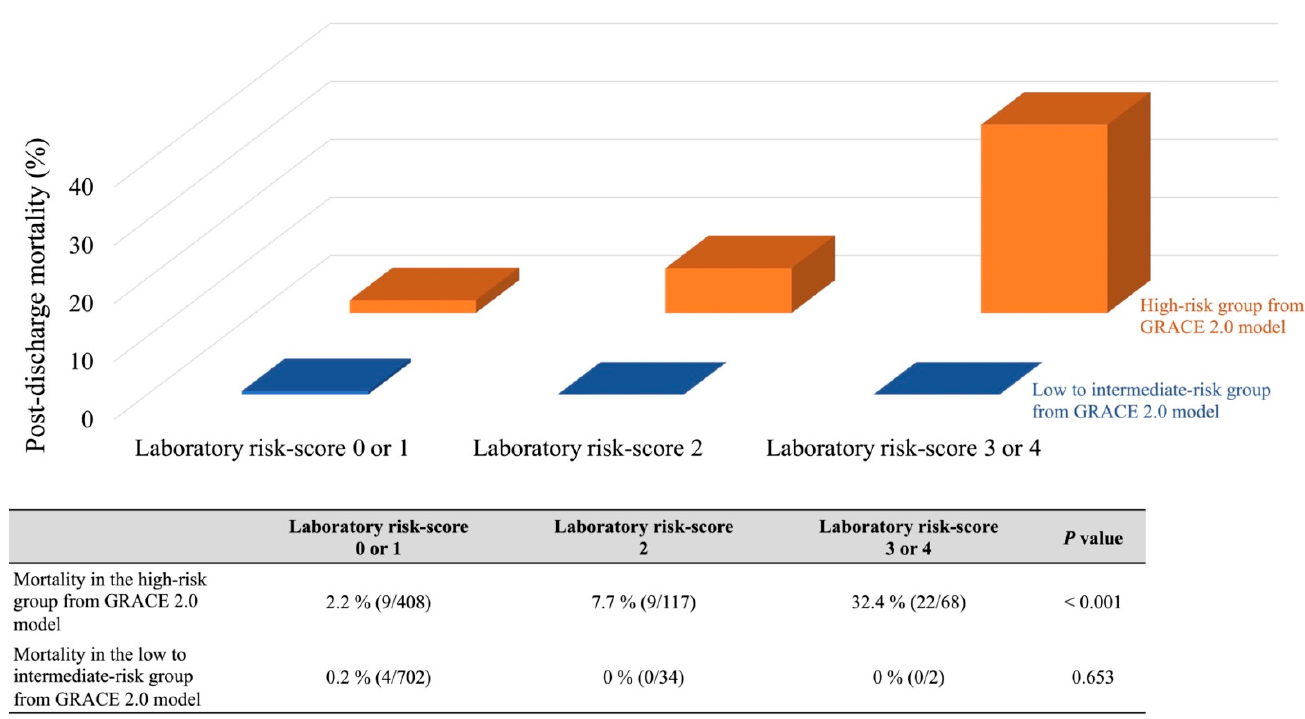
Figure 6. Dual-stratification by the laboratory model × the GRACE 2.0 model. All subjects from both study cohorts were stratified by the GRACE 2.0 model (high-risk > 8.0%, low to intermediate-risk ≤ 8.0%) and further subdivided into three subgroups by the laboratory model (low risk: 0–1 points, moderate risk: 2 points, and high risk: 3–4 points). The table below the graph shows the post-discharge one-year mortality for each subgroup. GRACE, The Global Registry of Acute Coronary Events